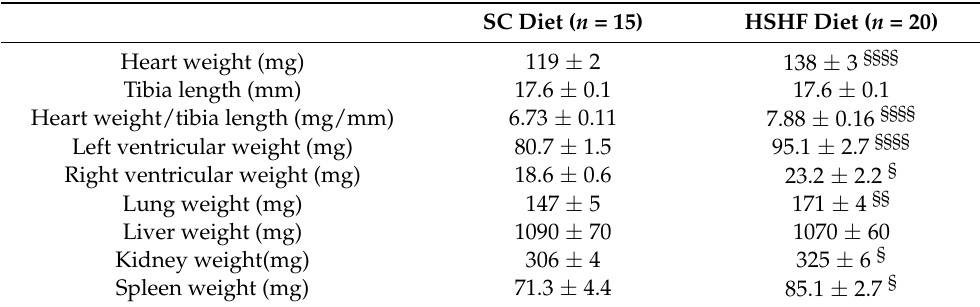
Table 1. Organ and tissue weights in female C57BL/6N mice fed the SC diet or the HSHF diet.